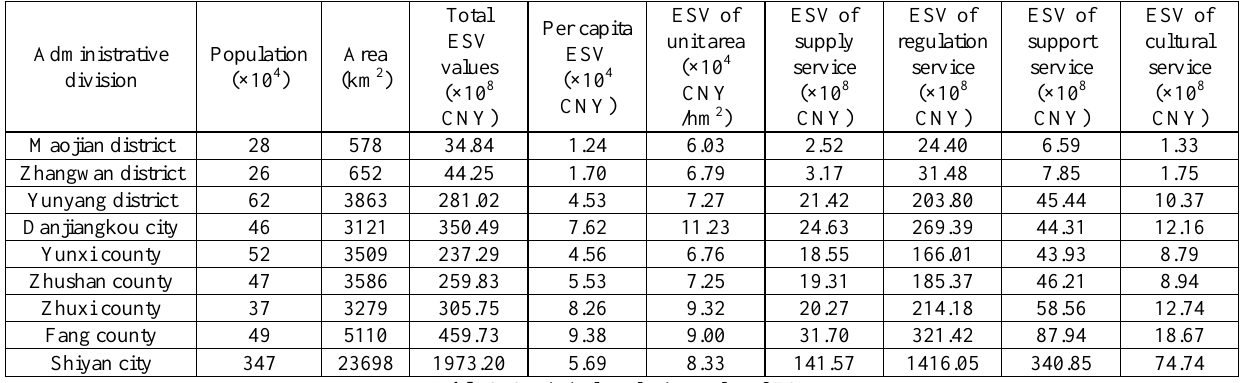
Table 3. Statistical analysis results of